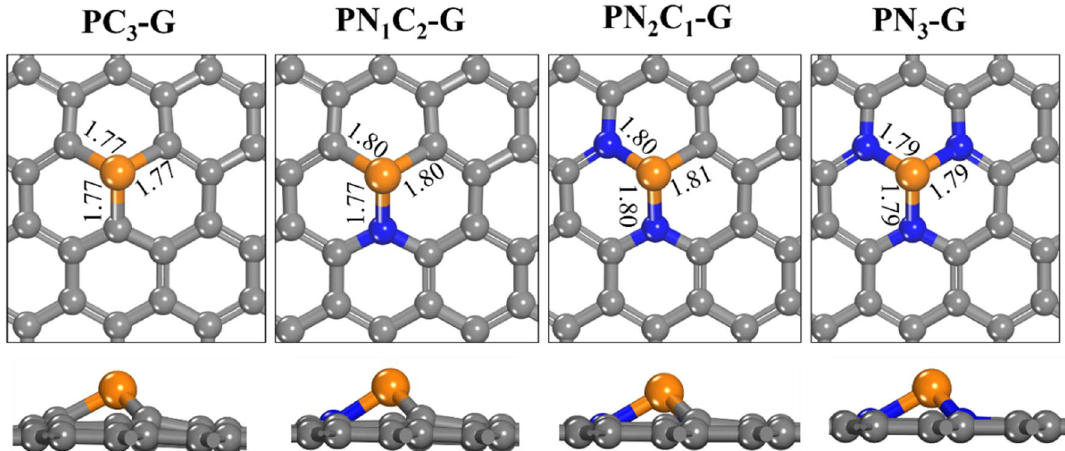
Figure 1. Optimized structures PC 3 -G , PN 1 C 2 -G , PN 2 C 1 -G , and PN 3 -G . All bond distances are in Å. Color scheme: C, gray; N, blue; P,